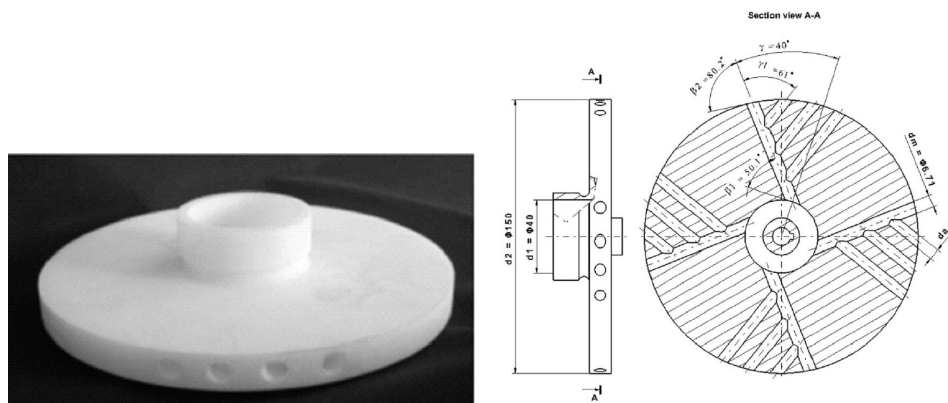
Figure 1: Geometry of the impeller 1 (I1)